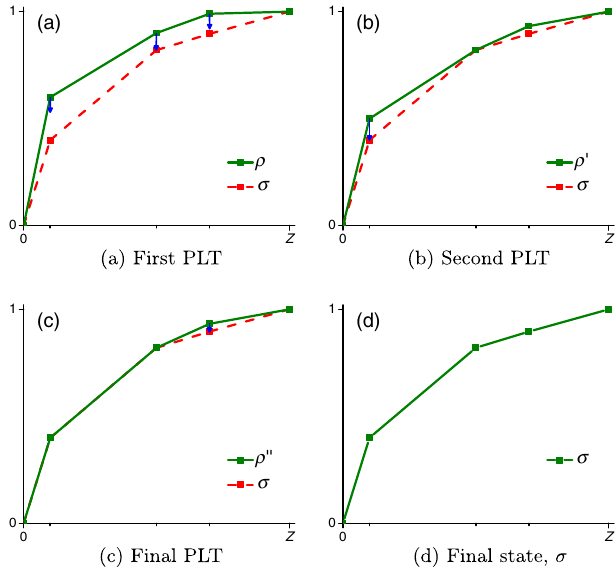
FIG. 6. Crude operations protocol for transforming between states with the same β order. If two states, ρ and σ , have the same β order and are such that ρ thermomajorizes σ , then ρ can be converted into σ using partial level thermalizations. First, a PLT is applied to ρ across the complete set of energy levels (a) lowering the thermomajorization curve of ρ until it meets that of σ (b). Next, a second PLT is applied to those energy levels to the left of this meeting point, again lowering the curve until it meets that of σ at a second point (c). By iterating this process, ρ is transformed into σ (d).